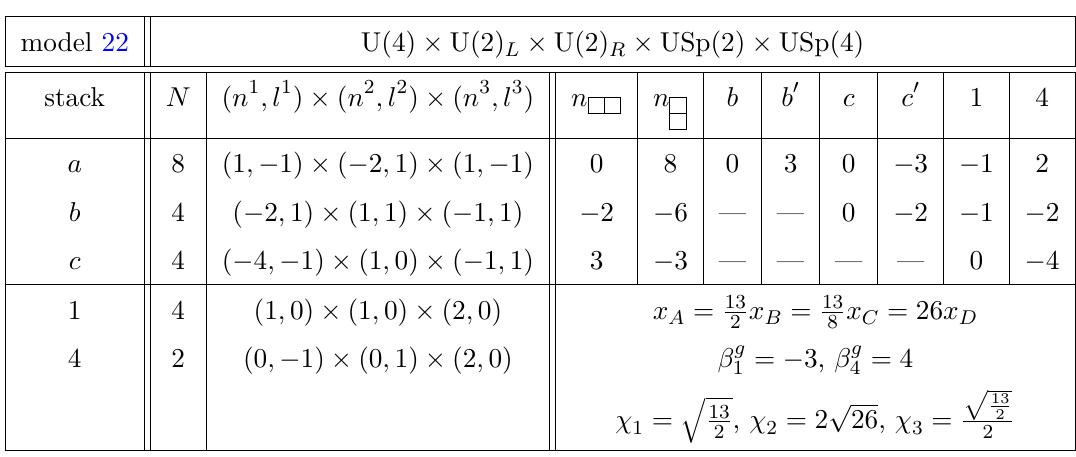
Table 22 . D6-brane configurations and intersection numbers of Model 22, and its MSSM gauge